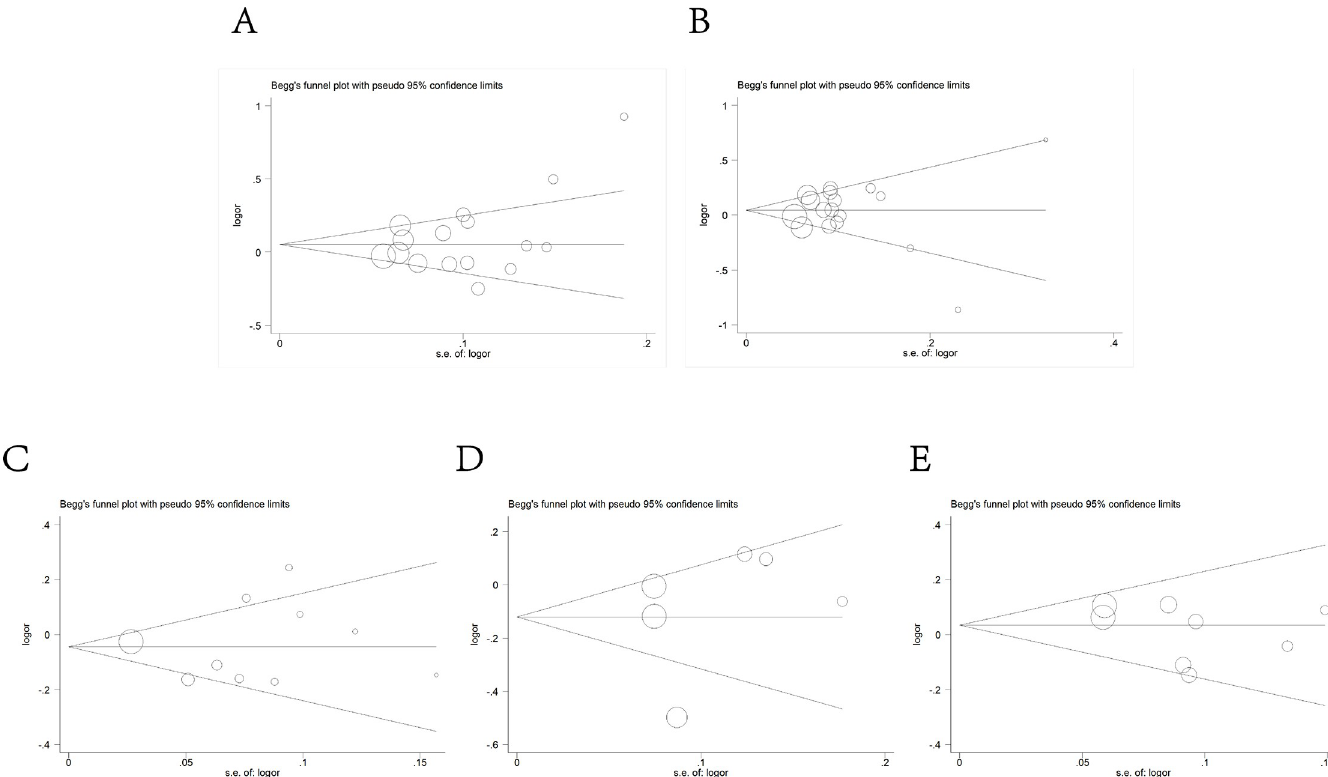
Fig 8. Begg’s funnel plot of publication bias test in the allele model. A: rs2839698; B: rs217727; C: rs2107425; D: rs2735971; E: rs3024270.